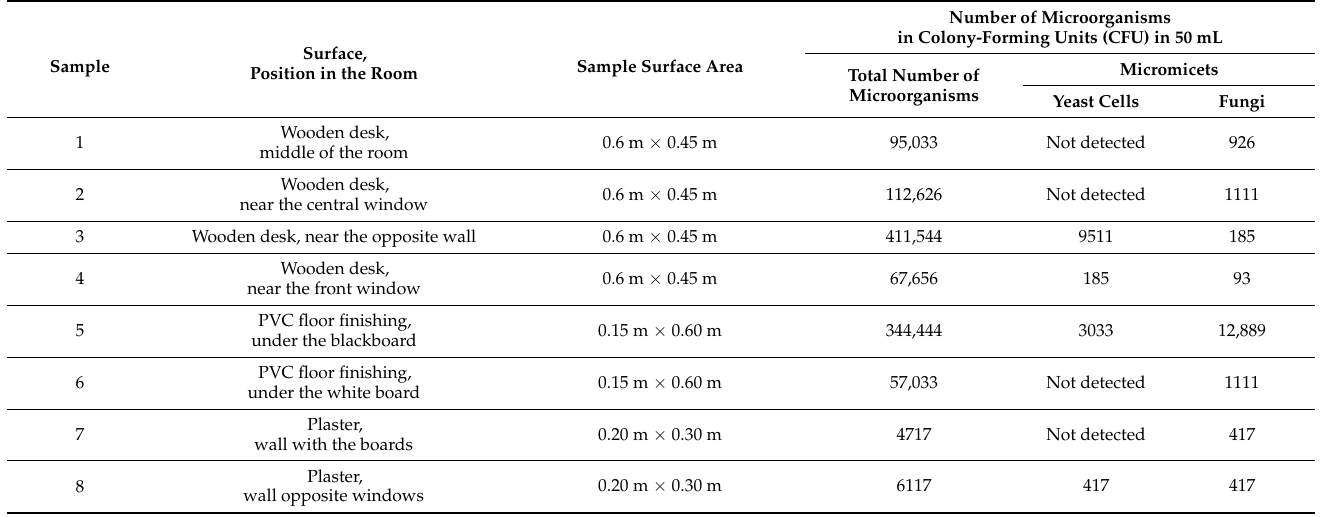
Table 2. Result of the microbiological testing in the